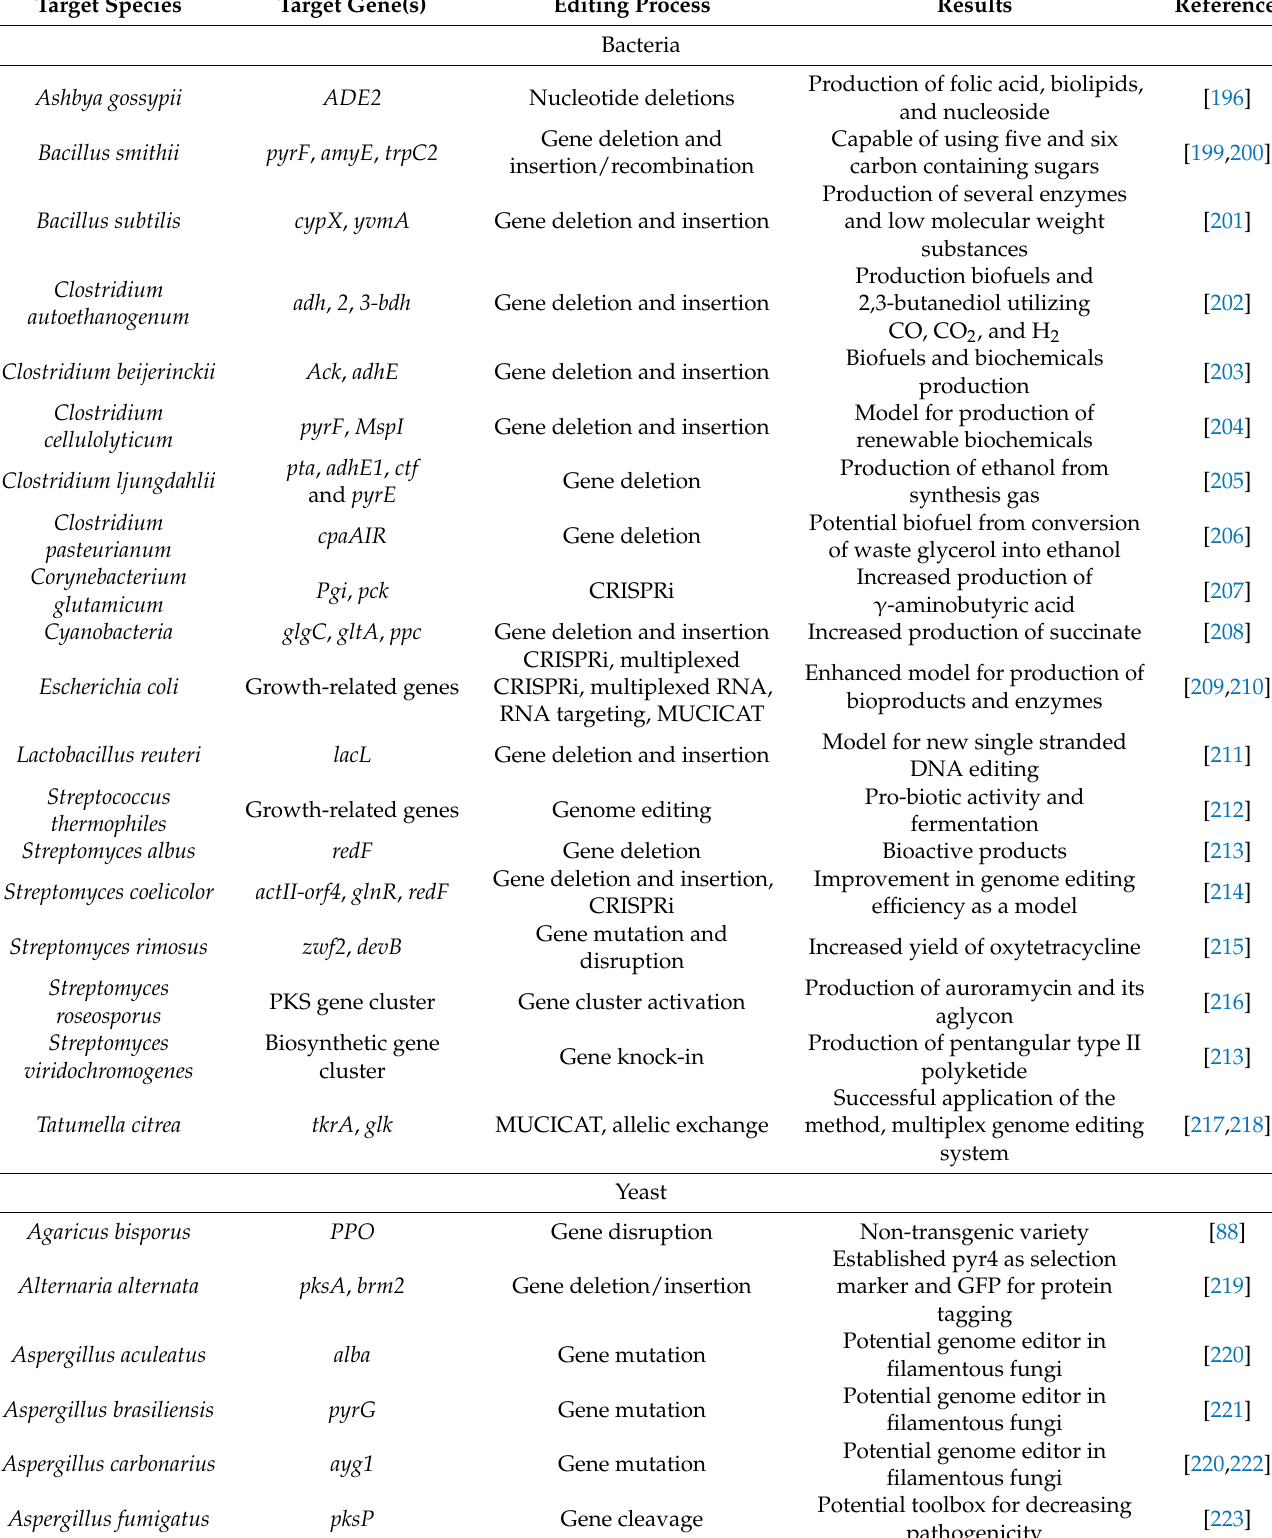
Table 7. The application of CRISPR–Cas in the food industry. Abbreviations: CRISPRi, CRISPR interference; GFP, green fluorescent protein; MUCICAT, multicopy chromosomal integration using CRISPR-associated